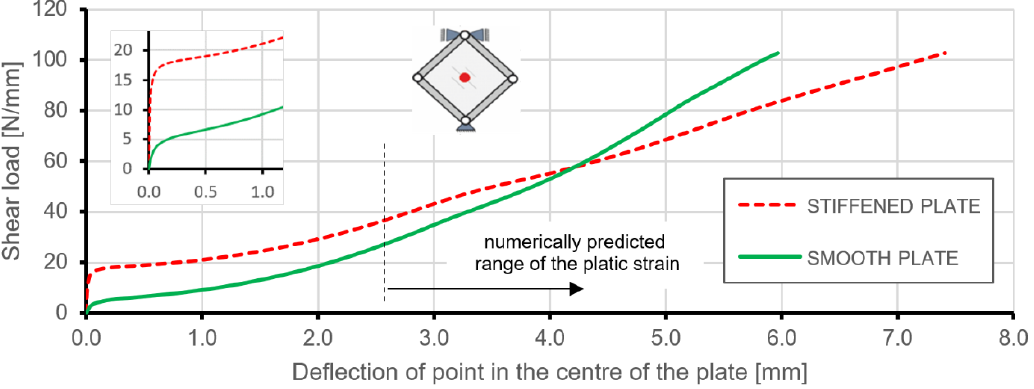
Figure 19. Comparison of shear load versus deflection obtained from FEM for stiffened and smooth plates.